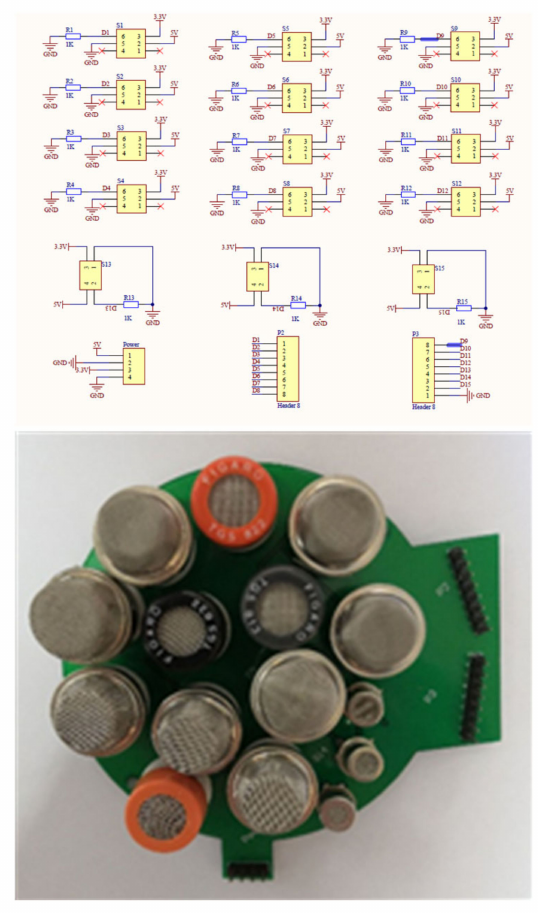
Figure 4. Sensor array schematic and appearance.